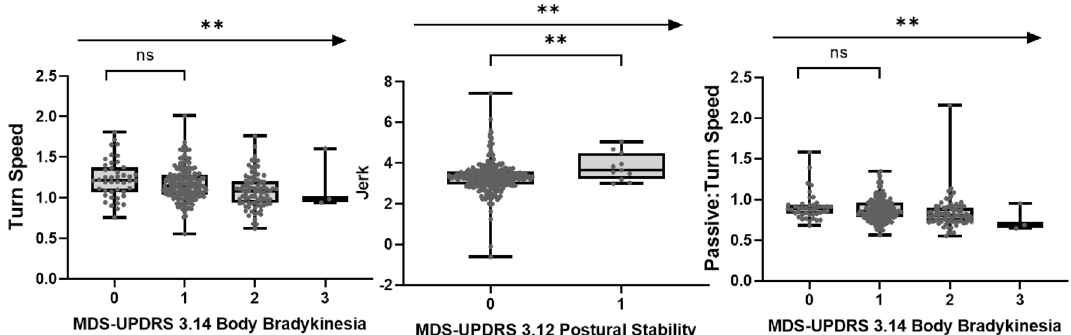
Figure 4. Association of sensor features from Phonation/Speech and eSDMT tests with corresponding clinical MDS-UPDRS measures at baseline (ns = P > 0.05; * = P ≤ 0.05; ** = P ≤ 0.01; *** = P ≤ 0.001; **** = P ≤ 0.0001).